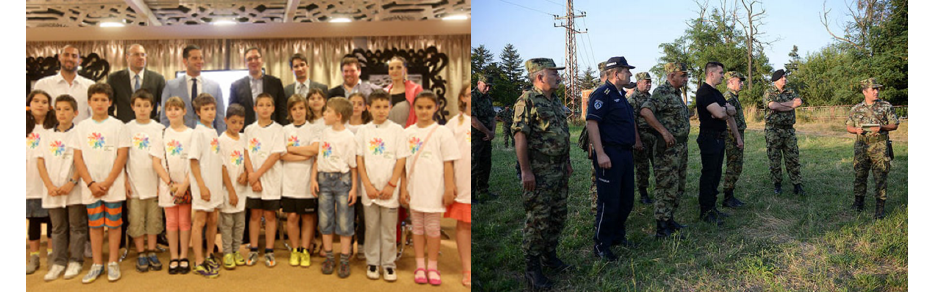
Figure 2d – Support of the Government in all other situations Рис . 2 г – Государственная поддержка в других